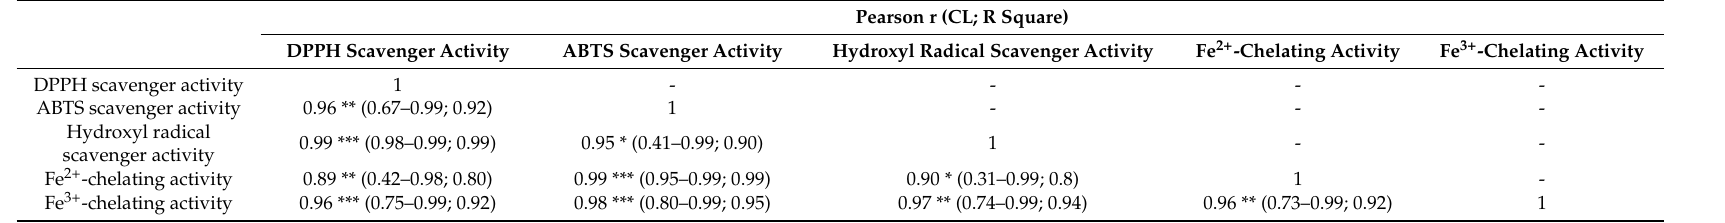
Table 5. Pearson correlation coefficient among antioxidant activity assays for DR2B extract.